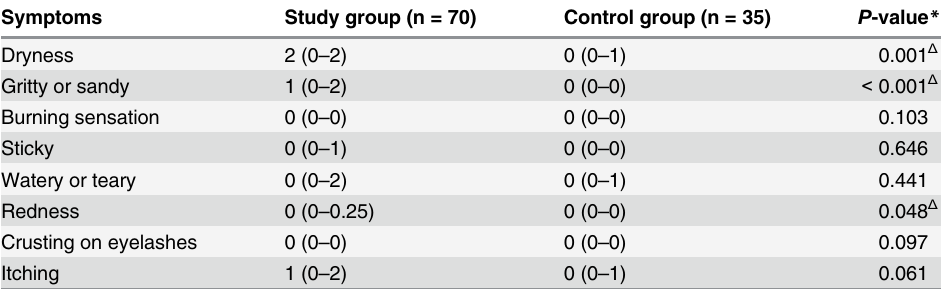
Table 4. Ocular surface symptoms in the study and control